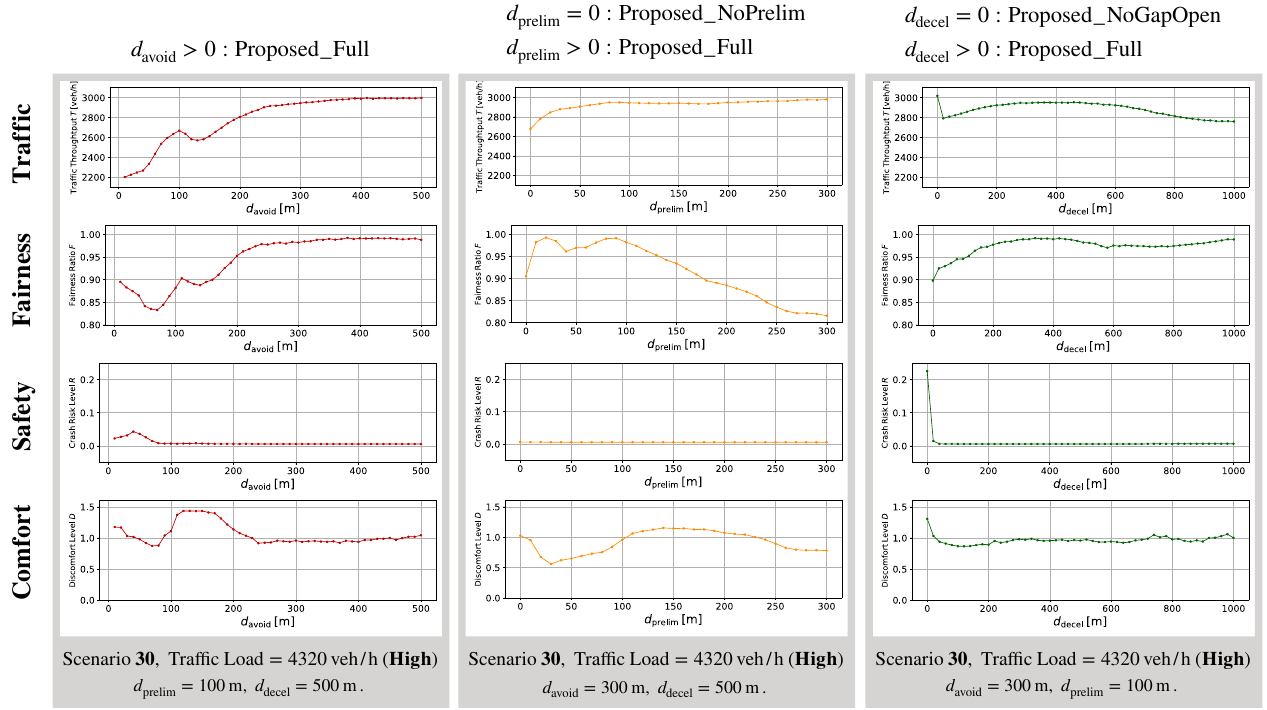
Figure 11. Simulation results showing impact of zone sizes under fixed traffic loads, CV penetration ratio =